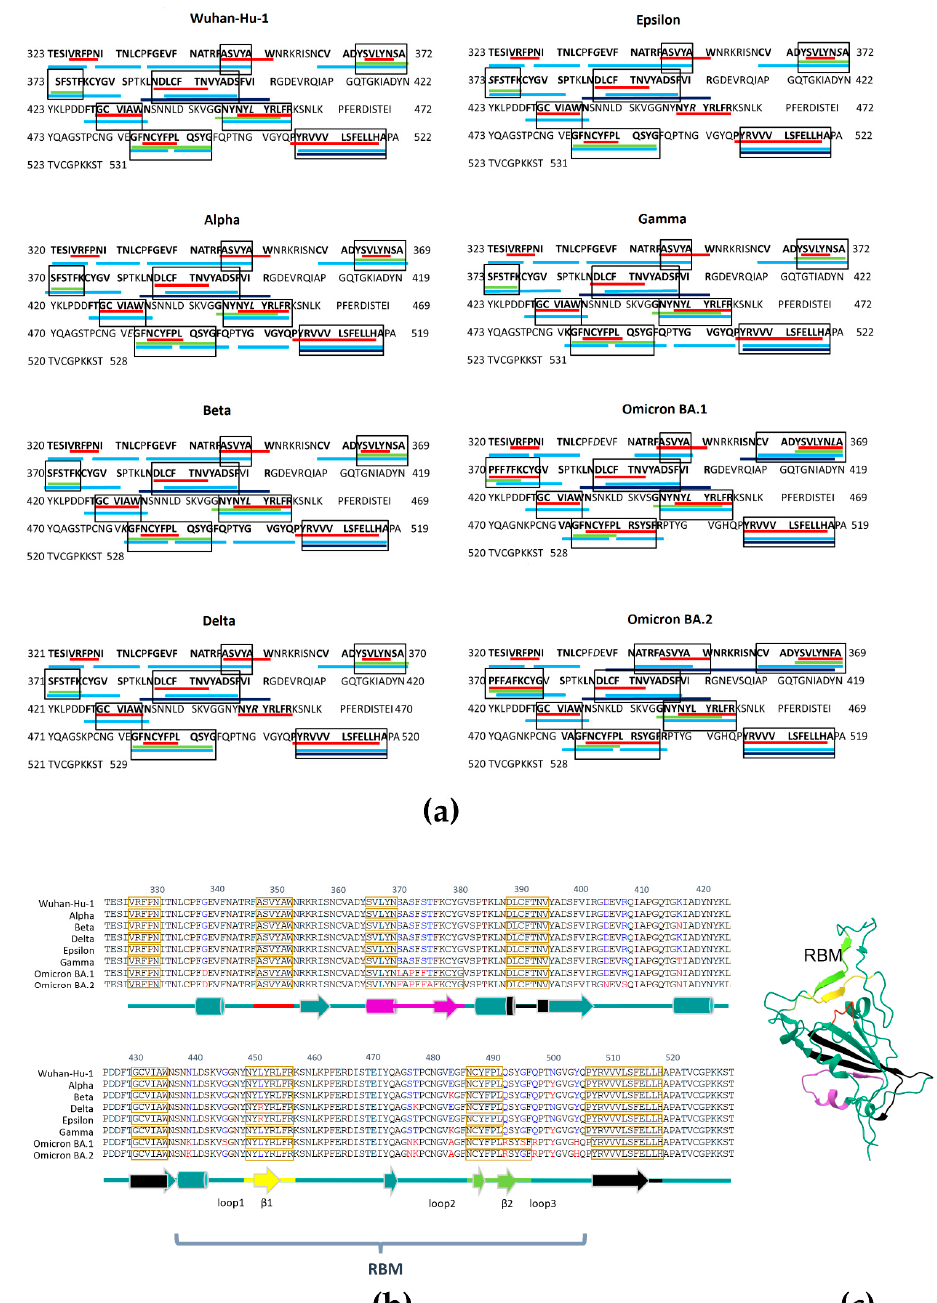
Figure 2. ( a ) Amyloidogenicity of Spike RBDs of different variants of SARS-CoV-2 as assessed by FoldAmyloid (red), Waltz (green), AGGRESCAN (light blue), and PASTA 2.0 (dark blue). ( b ) Alignment of SARS-CoV-2 variants’ Spike RBDs with amyloidogenic regions (boxed) predicted by FoldAmyloid. The secondary structure of Spike RBD is shown in cyan under the sequence. Amyloidogenic tracts 348–353 a.a. (red), 366–381 a.a. (magenta), 388–395 a.a. (black), 431–436 a.a. (black), 450–457 a.a. (yellow), 487–497 a.a. (light green), and 508–519 a.a. (black) are highlighted. Loop 1, Loop 2, Loop 3, β 1, and β 2 are as in [81]. ( c ) The 3D architecture of Omicron RBD according to the structure 7T9L (https://www.rcsb.org/3d-view/7T9L/1, accessed on 20 June 2022) with amyloidogenic tracts colored as in ( b